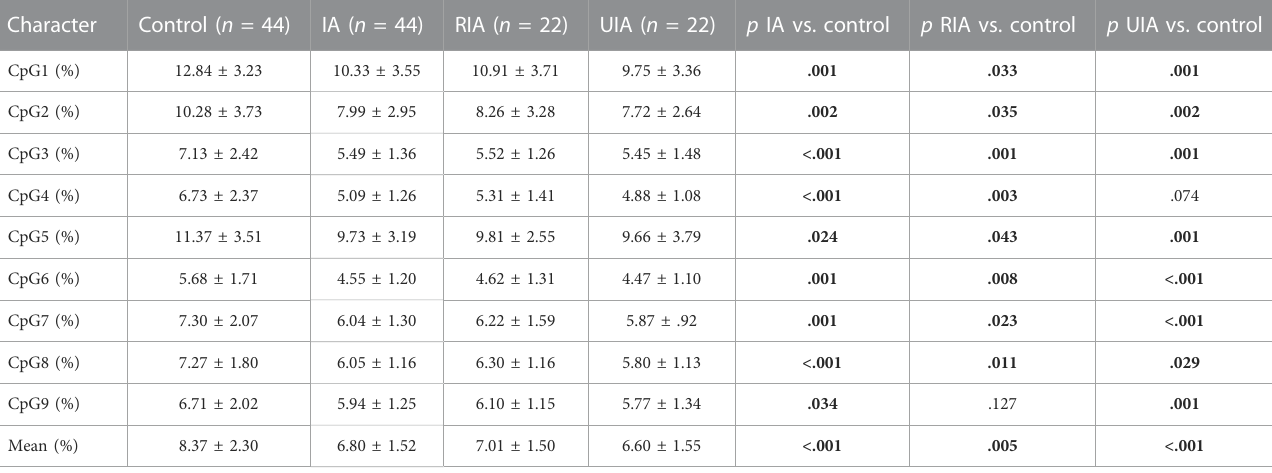
TABLE 2 DNA methylation differences of nine CpGs dinucleotides of GSTA4 gene between IAs and controls. Character